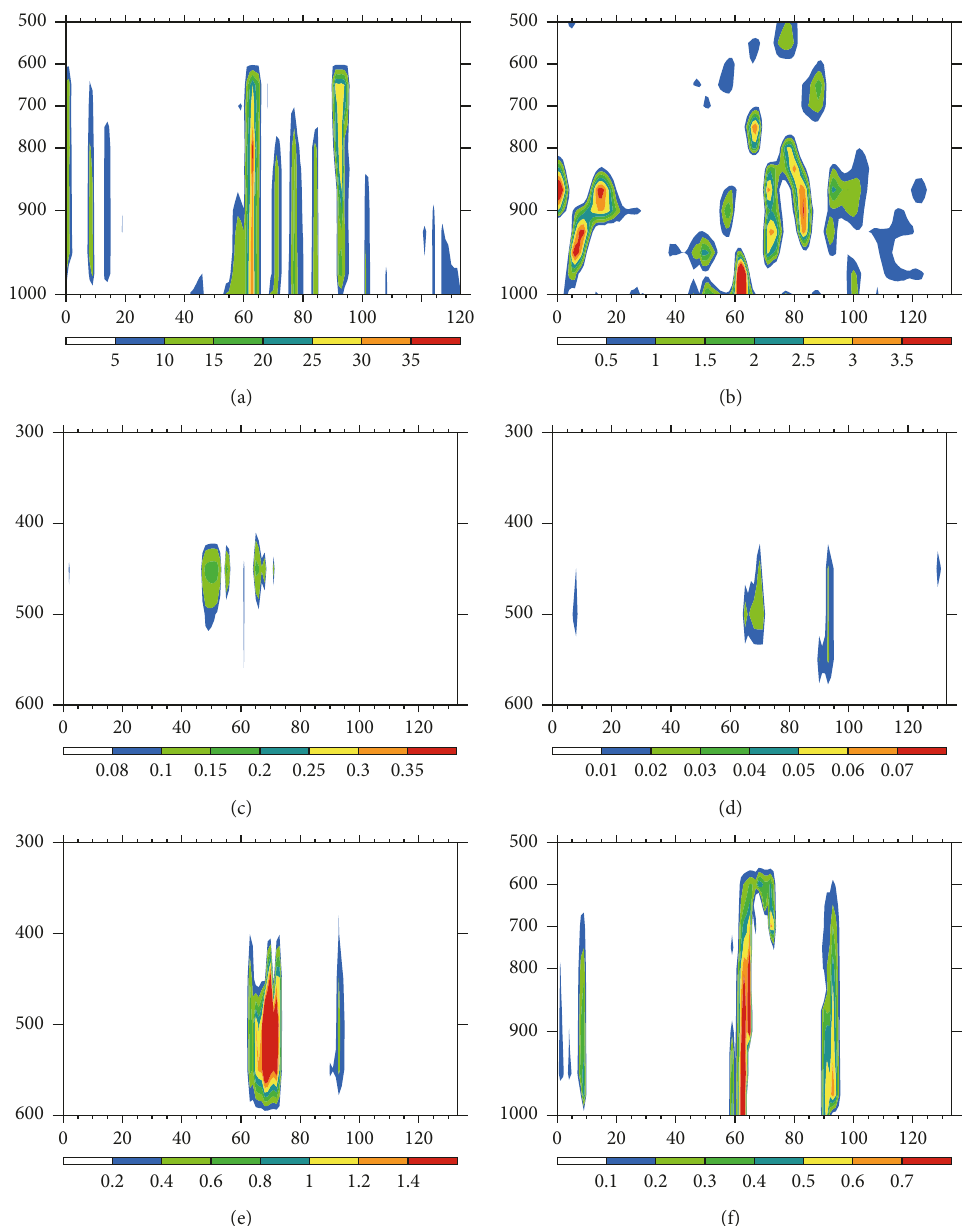
Figure 8: Cross sections of increments of radar echoes (a) (unit: dBZ), specific humidity (b) (unit: g/kg), and cloud hydrometeors ((c) cloud water, (d) cloud ice, (e) snow, and (f) rainwater, unit: g/kg) along line MN in Figure 3(a) at 0000 UTC 4 July 2014. The horizontal axis is the distance from line EF (Figure 3(a)) (unit: 10km). The vertical axis is pressure (unit: